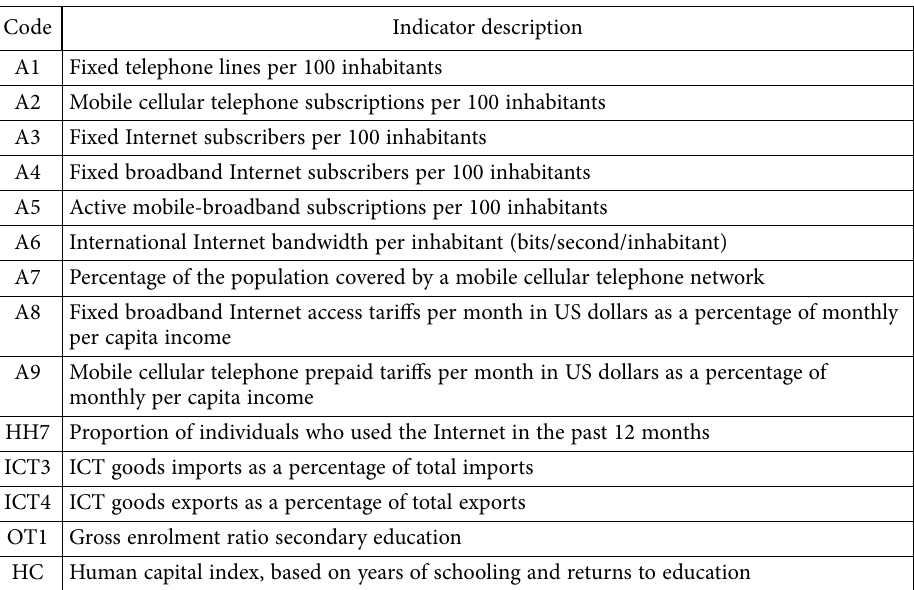
Table 1. ISLD single indicators. In comparison with the original list, A2 and A5 have been added and HC replaces OT2 (Gross enrolment ratio in tertiary education)